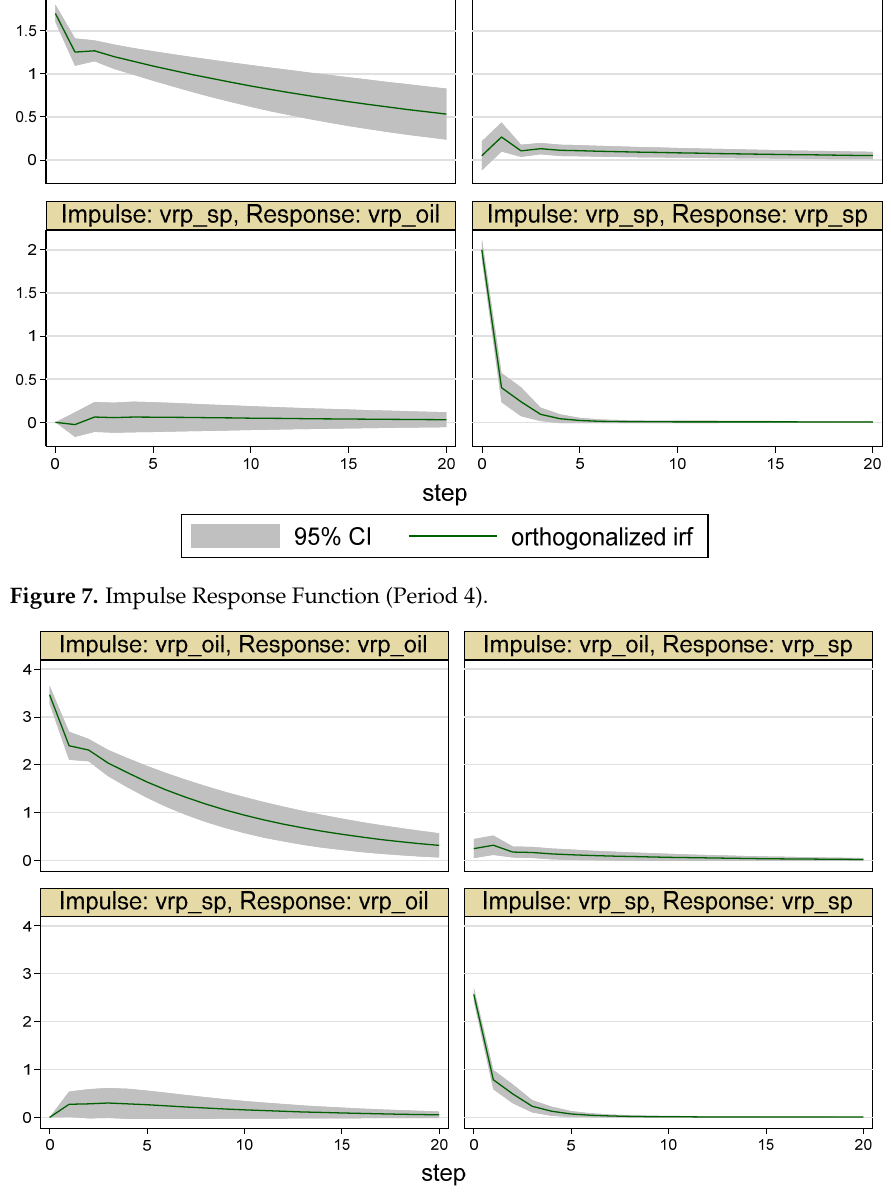
Figure 8. Impulse Response Function (Period 5). Notes: Vrp_oil (resp. vrp_sp) represents volatility risk premium of oil (resp. stock). The solid line represents orthogonalized impulse response functions and the gray area represents their 95% confidence intervals. The above-right graph shows the impulse response functions of vrp_sp to vrp_oil. The below-left graph shows the impulse response functions of vrp_oil to vrp_sp.